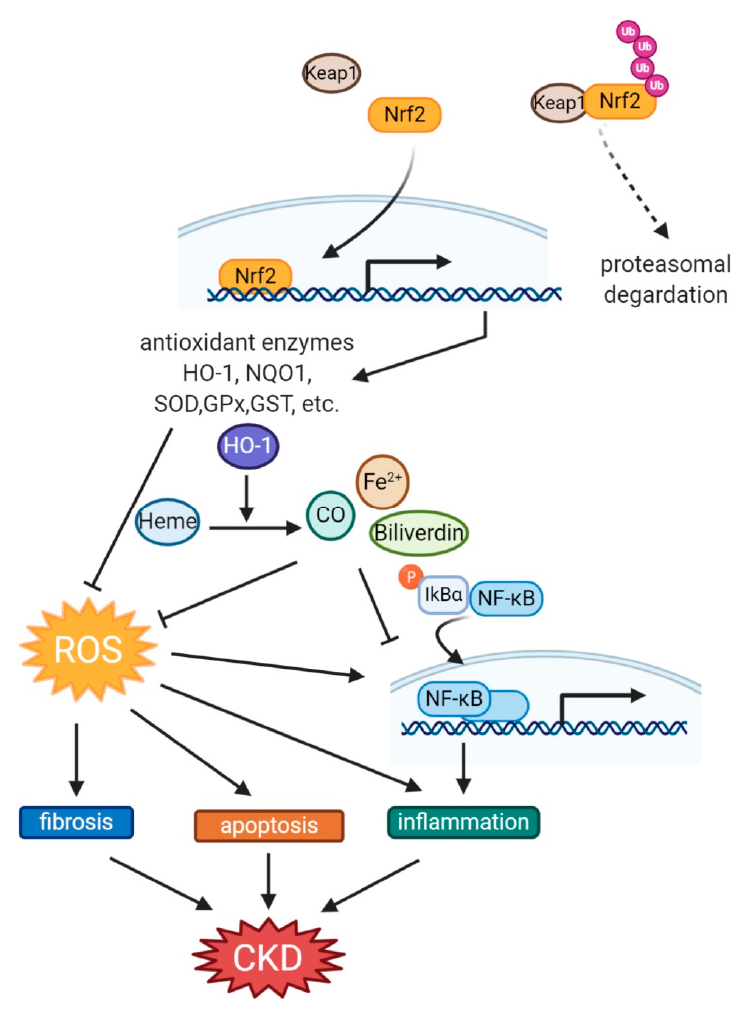
Figure 2. The protective mechanism via the Nrf2-HO-1 pathway on CKD. When Keap1, which targets Nrf2 for ubiquitination and proteasomal degradation, is decreased or inactivated, phosphorylated Nrf2 is translocated into the nucleus, and transcription of downstream antioxidant enzymes is activated. In particular, by HO-1, fibrosis, apoptosis, and inflammation are attenuated either directly or indirectly through inhibition of OS, thus improving kidney damage. CKD, chronic kidney disease; CO, carbon monoxide; GPx, glutathione peroxidase; GST, Glutathione-S-transferase; HO-1, Heme oxygenase-1; Nqo1, NADPH quinone oxidoreductase; Nrf2, nuclear factor erythroid 2-related factor 2; SOD, superoxide dismutase; ROS, reactive oxygen species. Nrf2-induced HO-1 may protect the kidney from remote organ injury in mice and rats [99]. HO-1 induction could be a potential therapeutic approach to prevent CKD com- However, Nrf2-independent HO-1 expression has also been reported [108]. Bach1 is plications by activating antioxidative and antiapoptotic signaling. Yoh and colleagues regarded as a critical physiological repressor of HO-1. Higher levels of HO-1 mRNA speculate that the decrease in HO-1 expression might be associated with the pathogenesis of LN in Nrf2 − / − female mice [100]. Also, adenine-induced OS and inflammation were associated with kidney tubulointerstitial fibrosis with impairment of Nrf2 activation and downregulation of its target gene products, including HO-1 [60]. Small molecule activator of Nrf2, CDDO-Im (1-[2-cyano-3-,12-dioxooleana-1,9(11)-dien-28-oyl] imidazole), pro- tects against LPS-induced dysregulation of the innate immune response in mice. Specifi- cally, CDDO-Im treatment reduced LPS-induced ROS levels and inflammatory cytokines